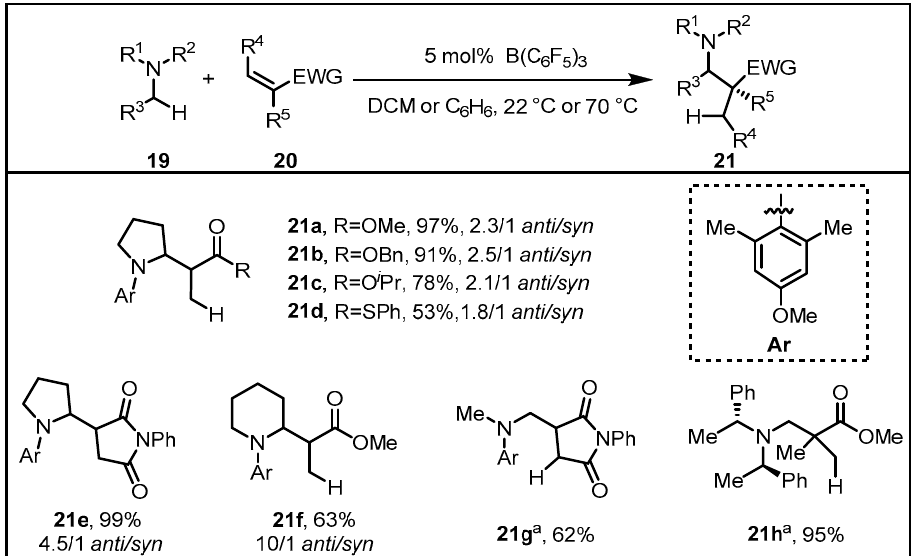
Figure 8. Coupling of N-alkylamines and α , β -unsaturated compounds through B(C 6 F 5 ) 3 -catalyzed hydride abstraction.